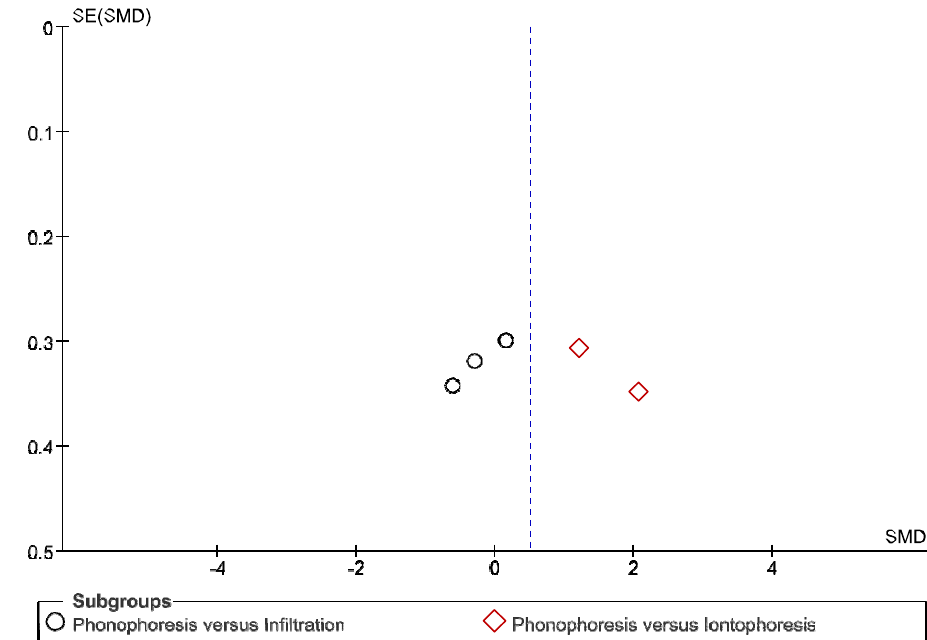
Figure 19. Phonophoresis for LMSensor.